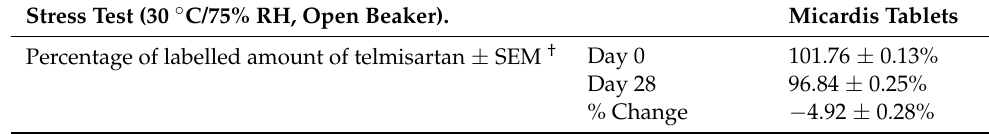
Table 3. Chemical content of Micardis ® tablets as percentage of labelled amount of telmisartan determined by HPLC. Stress Test (30 ◦ C/75% RH, Open Beaker).